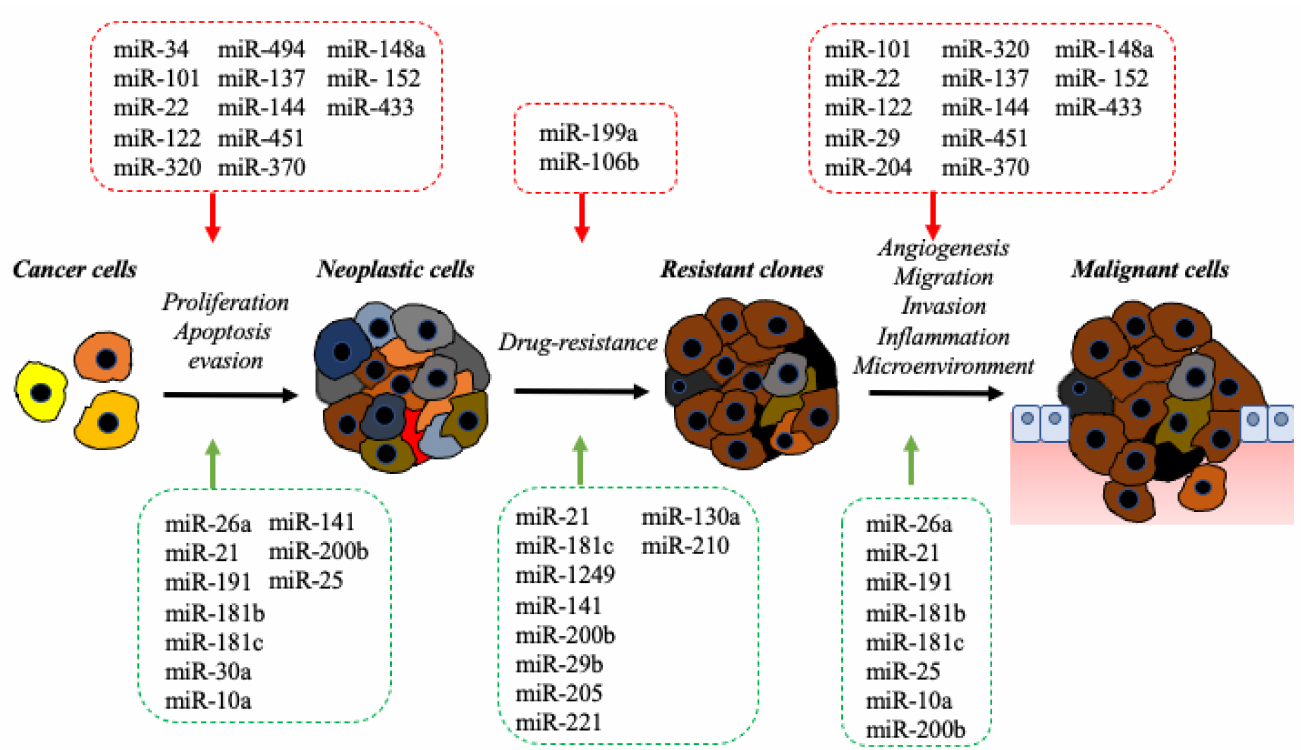
Figure 1. The impact of the miRNA in BDC